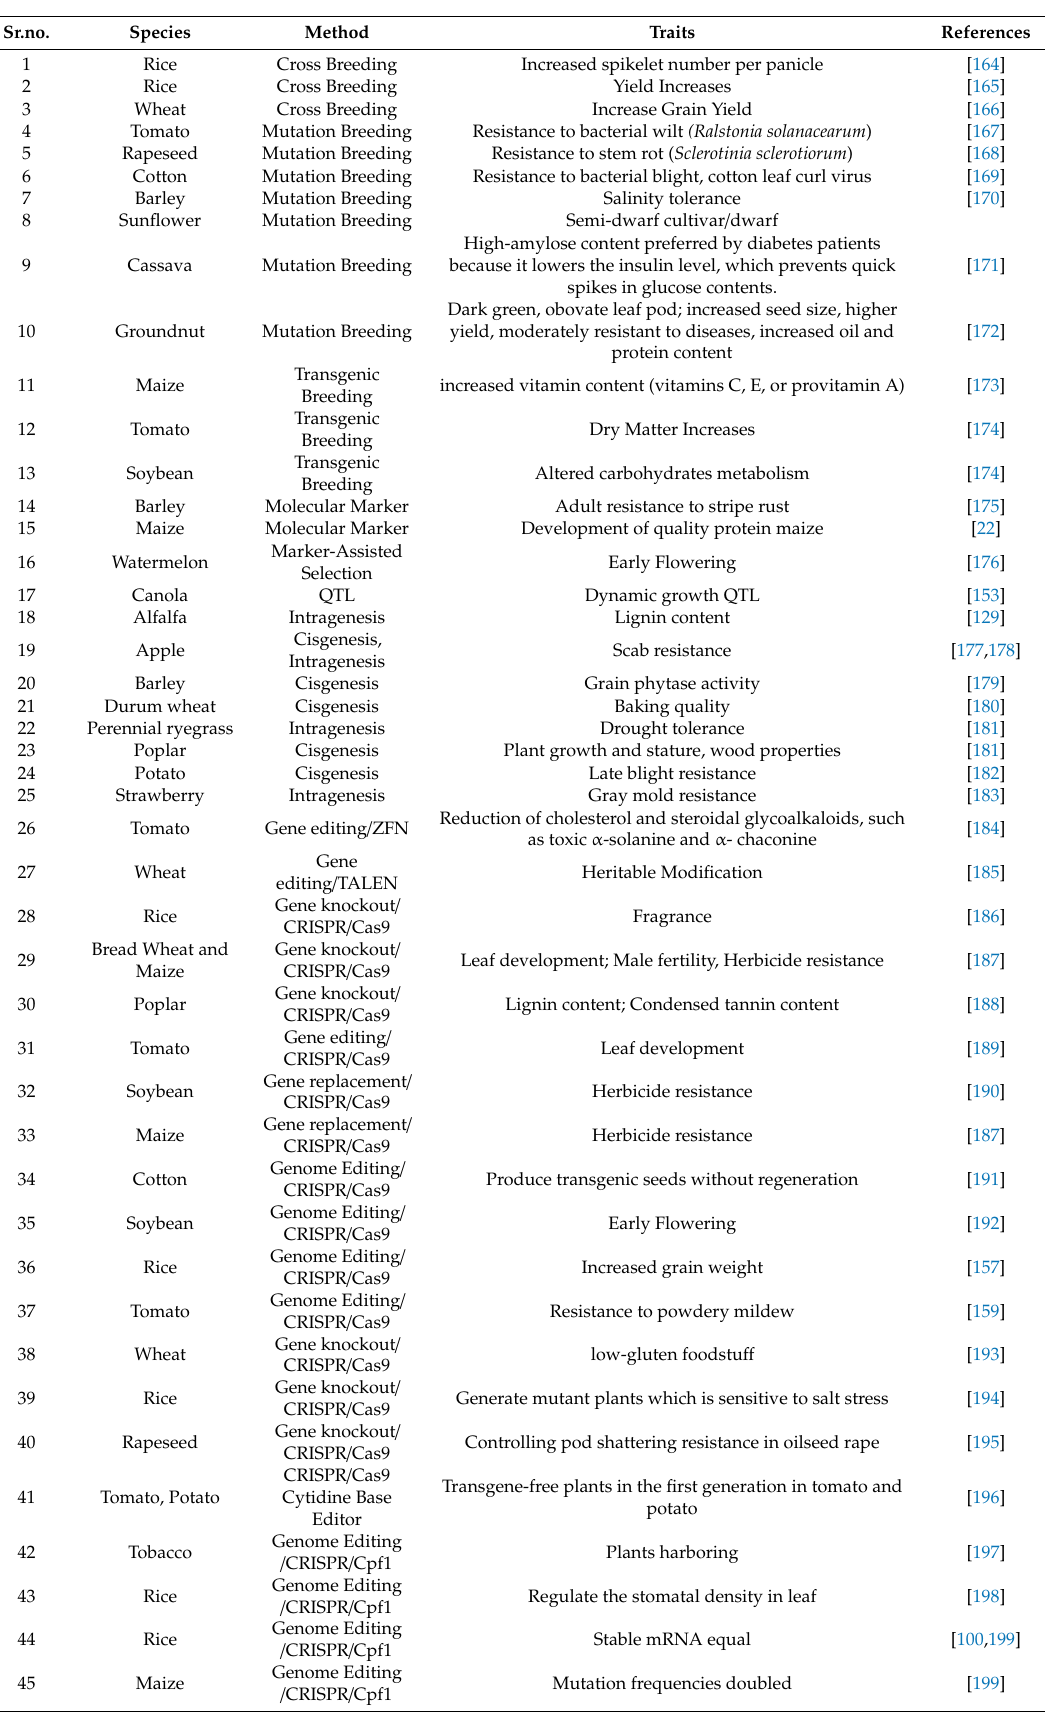
Table 2. Application of breeding techniques toward crop